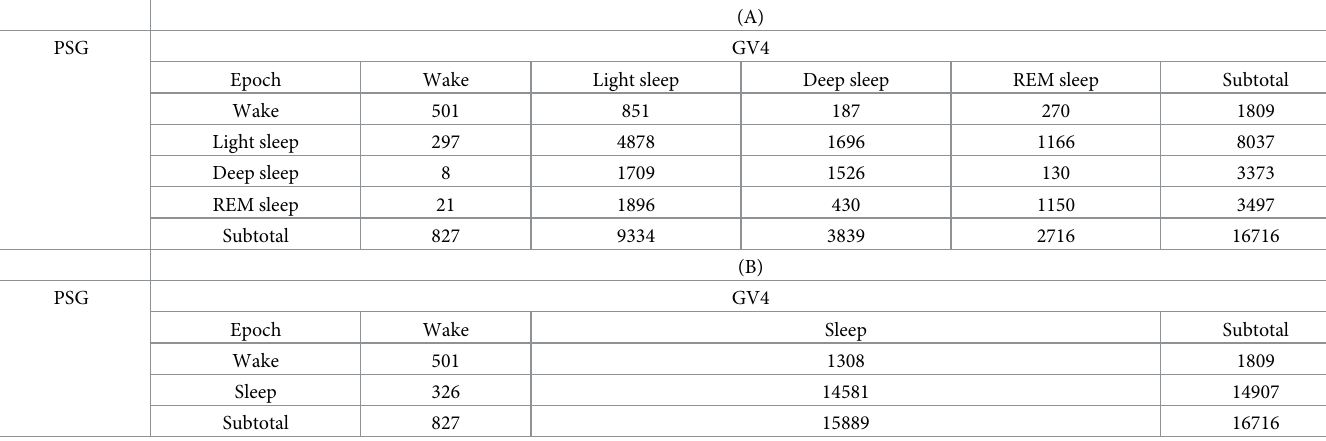
was compared to PSG N1 + N2 sleep, and GV4 “deep sleep” to PSG N3 sleep. Presented GV4 measures of SOL, REM latency, TIB, and SE were artificially constructed subsequent to data extraction (GV4 does not automatically generate these measures). SOL was calculated as the time from the PSG event mark until GV4 sleep onset, REM latency as the time from GV4 sleep onset until the first GV4 detected epoch of REM, TIB as the sum of SOL, WASO and TST, and SE as TST divided by TIB. These measures were calculated for clinical interest. “Wake” included wake periods before sleep onset (from the first compared epoch) and after sleep onset until both methods agreed on sleep end with 1 wake epoch. Linear regression was performed on each relationship between GV4 and PSG estimates providing R 2 values. Intraclass correlations (ICC) for sleep parameters were calculated using IBM SPSS Statistics (version 27) and were based on a single-rater, absolute-agreement, two- way random model. Table 4. Confusion matrices (inter-device agreement).